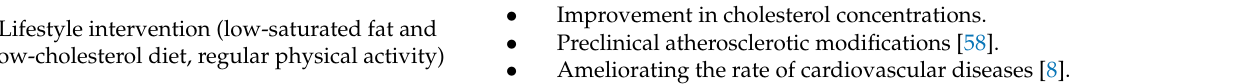
Table 2. Effects of lipid-lowering therapies on individual cardiovascular risk in children and adolescents. Lifestyle intervention (low-saturated fat and low-cholesterol diet, regular physical